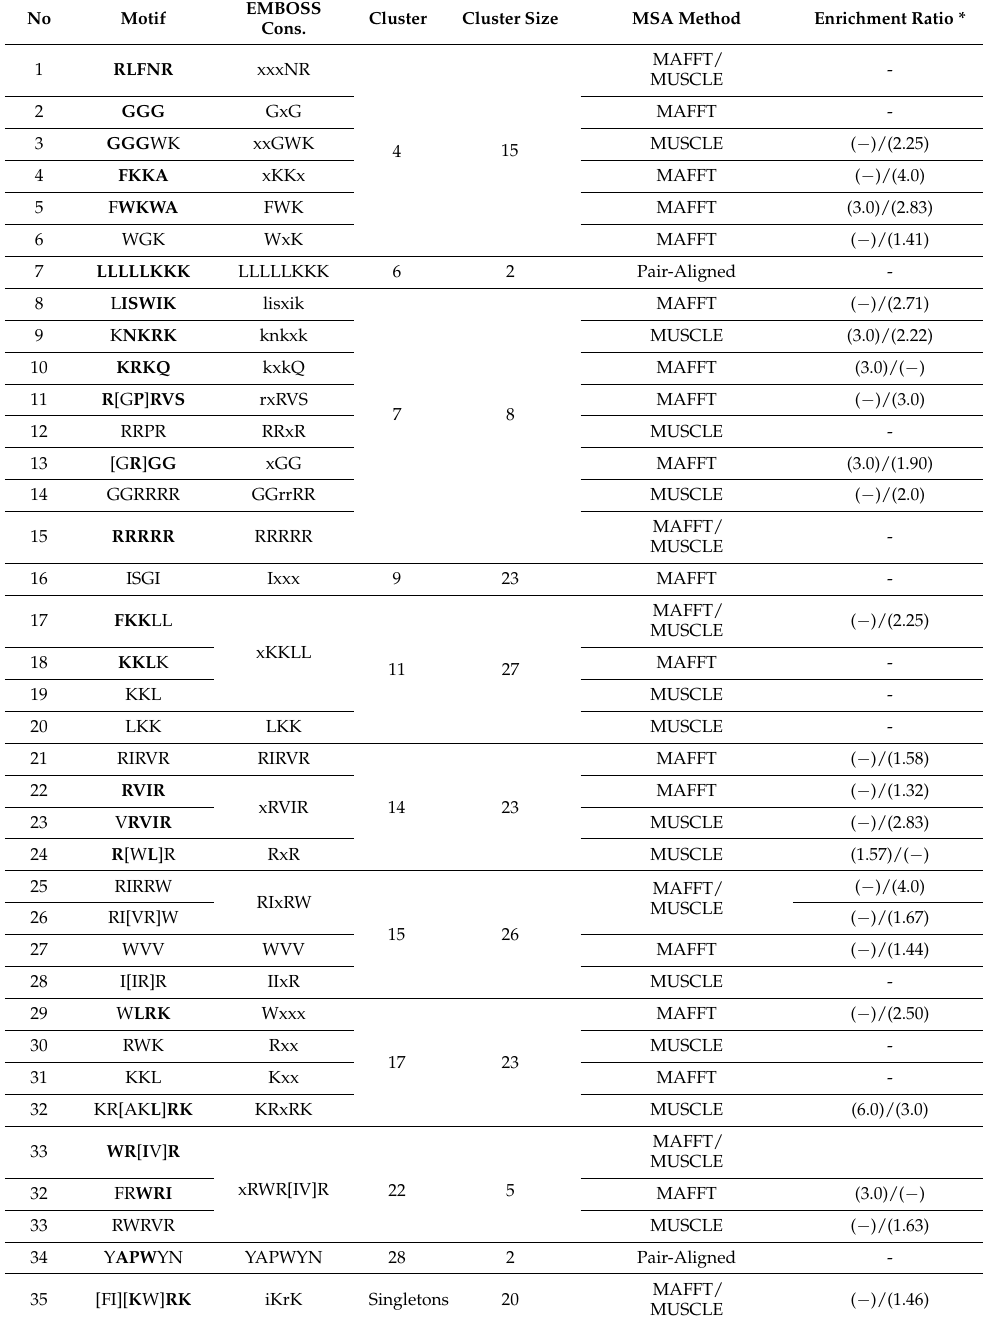
Table 5. Motifs discovered by multiple sequence alignment (MSA) in each network